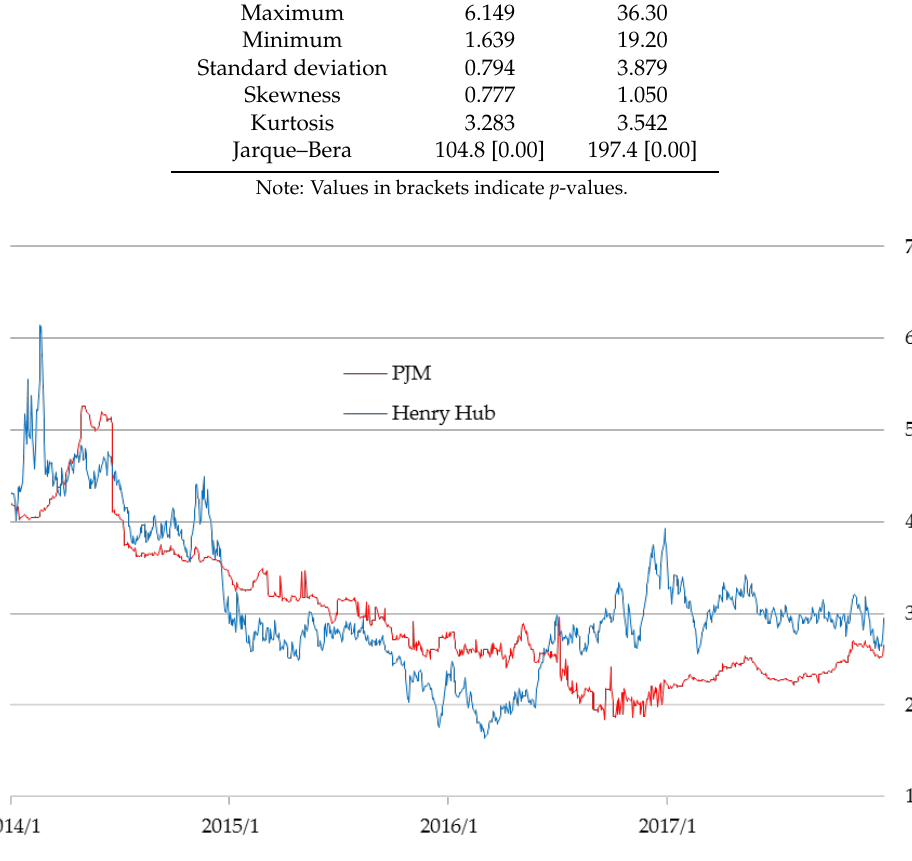
Figure 2. Prices of PJM futures and Henry Hub futures.